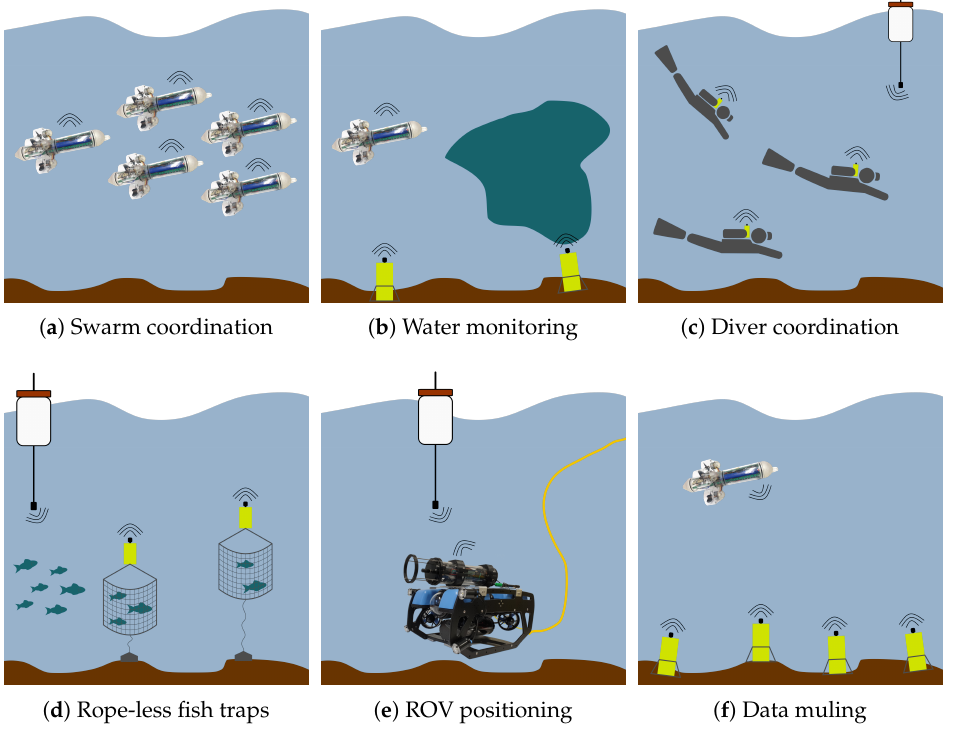
Figure 8. Example applications for low-cost acoustic modems. Table 4. Main applications of acoustic modems and positioning